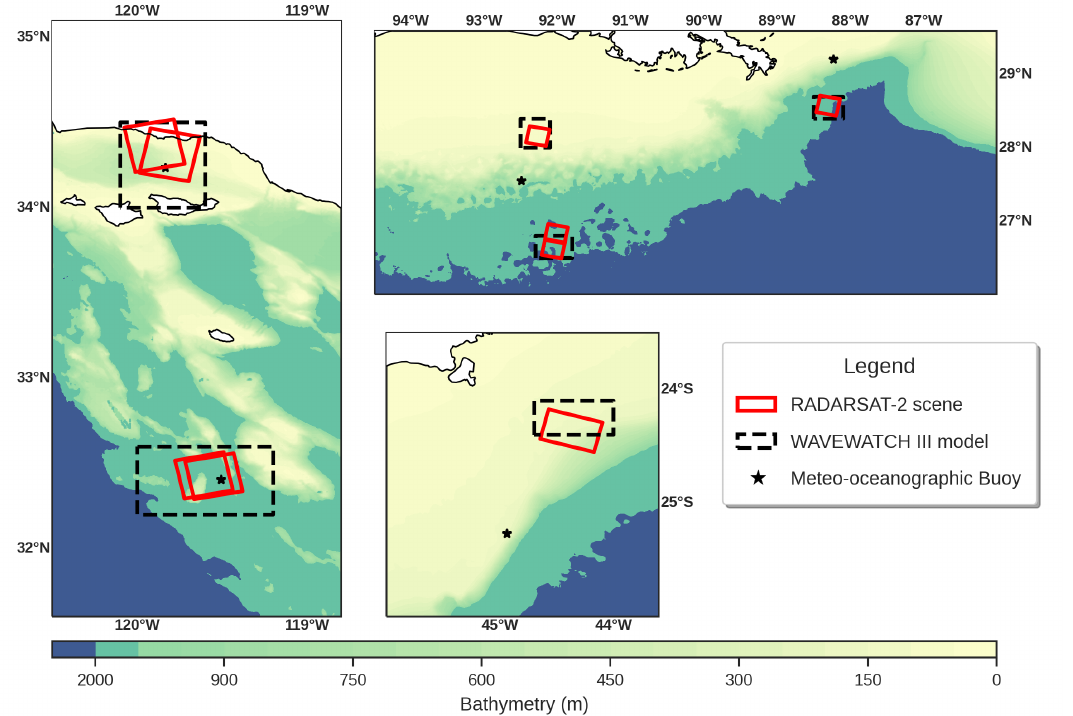
Figure 1. Study area used: ( left ) California coast; ( right and upper ) northern portion of the Gulf of Mexico; and ( right and bottom ) portion of the Santos Basin,